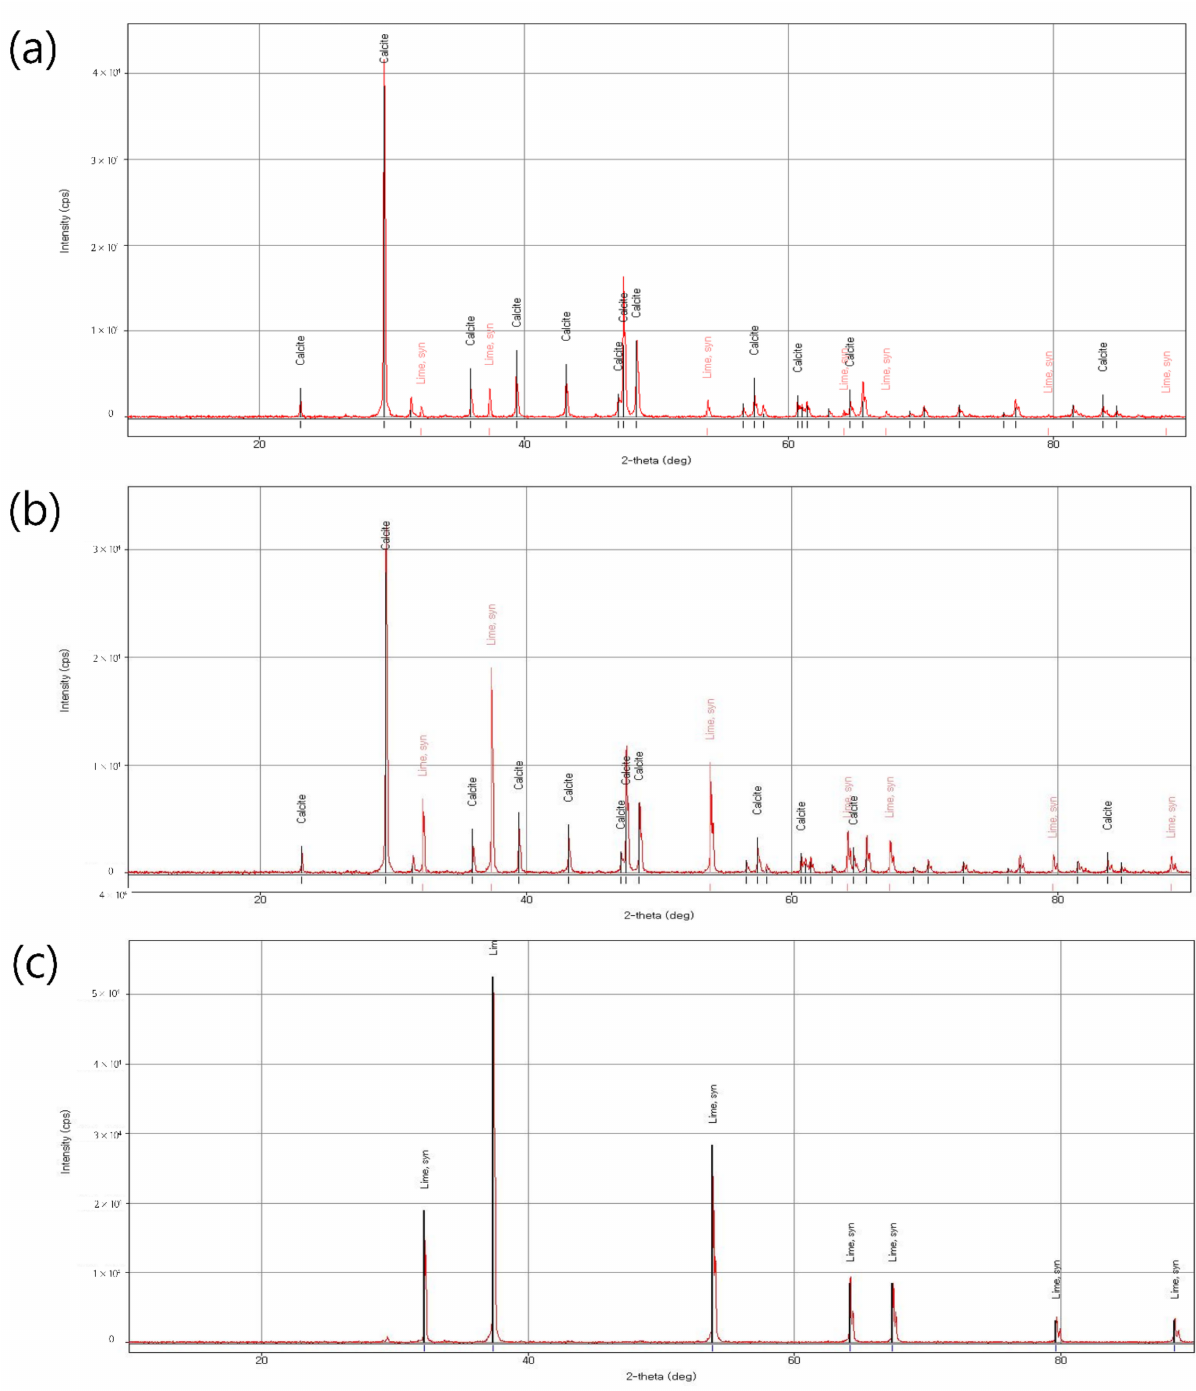
Figure 12. X-ray diffractograms (XRD) of calcinated samples: ( a ) CC6. ( b ) CC7. ( c )